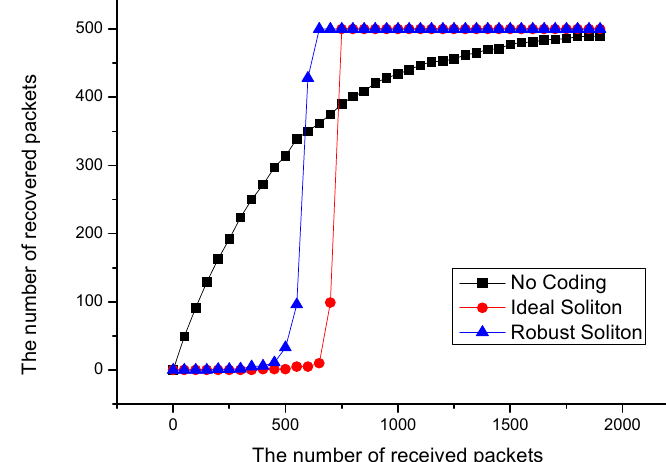
Figure 5. Decoding performance of different